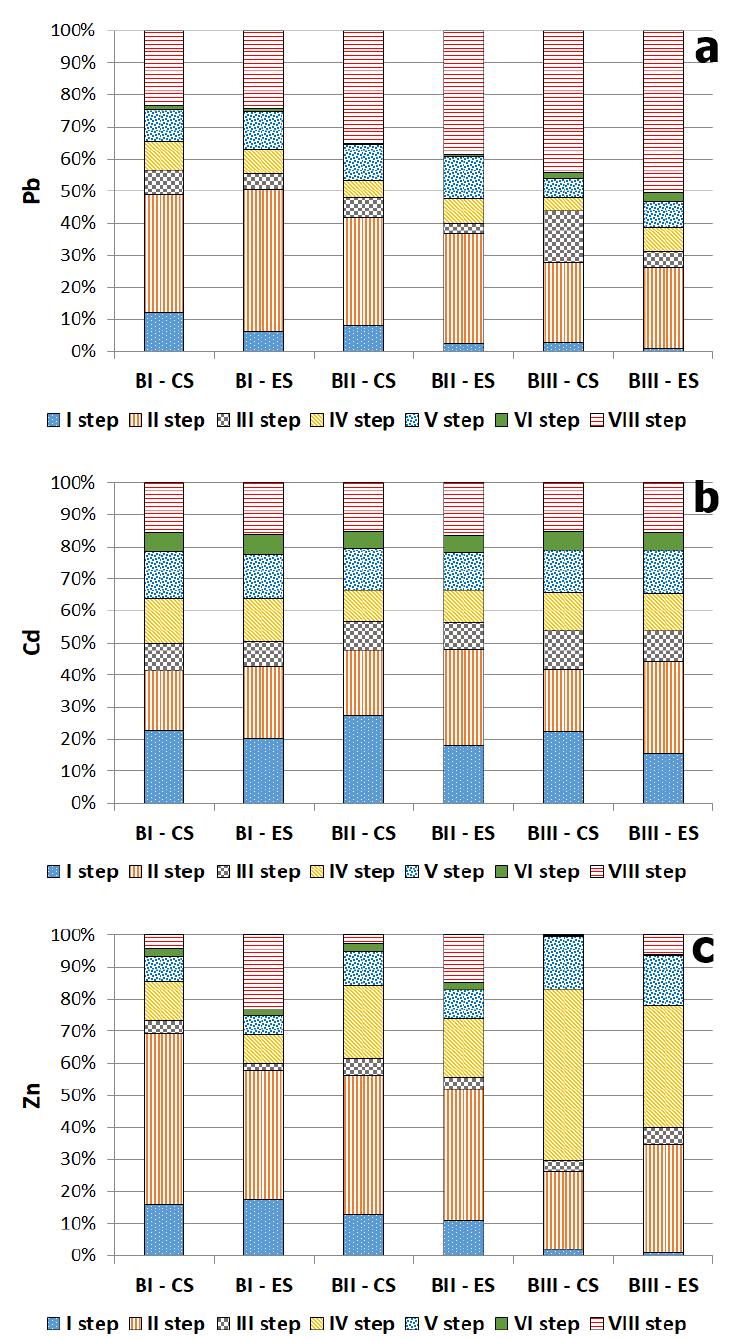
Figure 5. Contents of Pb ( a ), Cd ( b ) and Zn ( c ) in individual stages of selective extraction in soil samples (ES—results for the experimental system, CS—results for the control system). Step I: